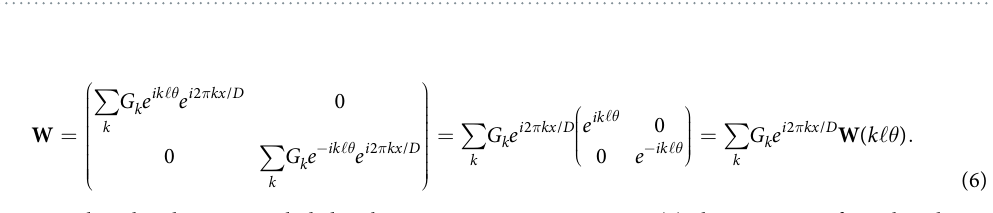
Figure 2. Experimental generation of 6 different vector beams. (a) Capture without analyzer; (b) Capture with vertical linear